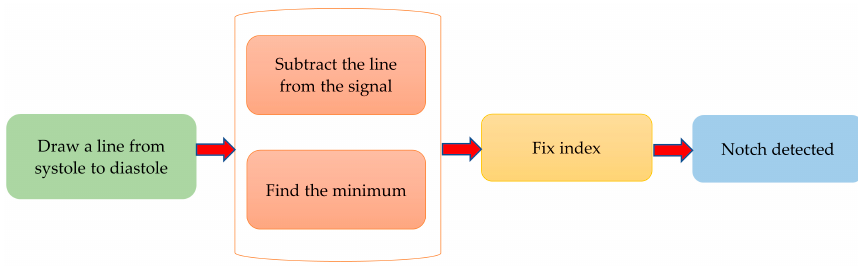
Figure 8. Algorithm of notch detection.